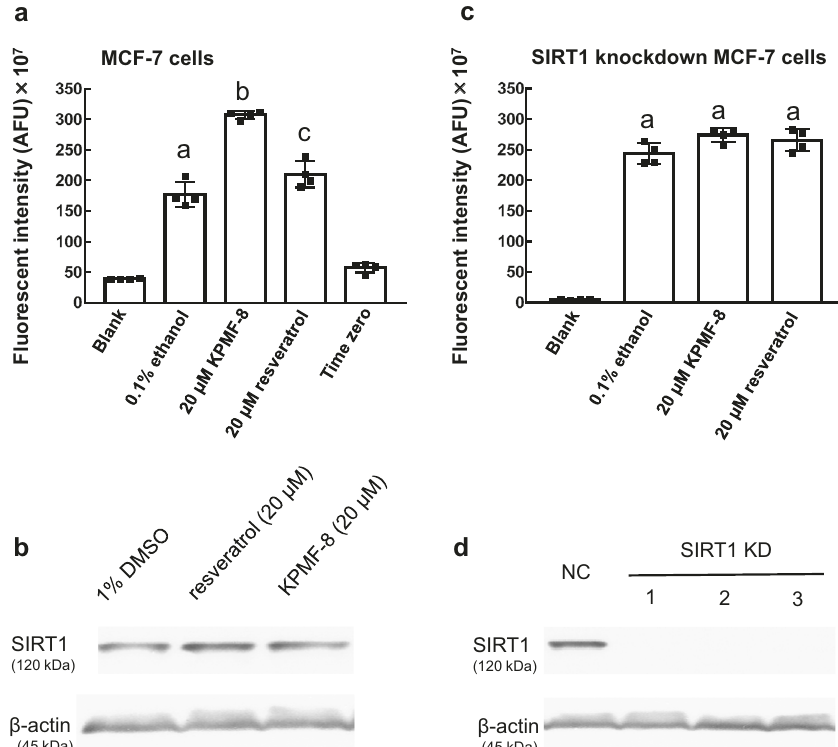
Fig. 9 Stimulation of intracellular deacetylase activity within normal or SIRT1 knockdown MCF-7 cells by externally added KPMF-8 or resveratrol. a normal MCF-7 cells. c SIRT1 knockdown MCF-7 cells. The SIRT1 knockdown MCF-7 cells in c were obtained after siRNA2 treatment. Results are presented as fl uorescent intensities (Mean ± SD, n = 4 biologically independent samples). Means with the same letter are not signi fi cantly different ( p < 0.05). b Western blot analysis of SIRT1 expression in normal MCF-7 cells treated by resveratrol or KPMF-8. d Western blot analysis of SIRT1 in control siRNA (NC) transfected MCF-7 cells and SIRT1 knockdown MCF-7 cells obtained using siRNA1, 2, and 3, which are labeled as 1, 2, and 3,